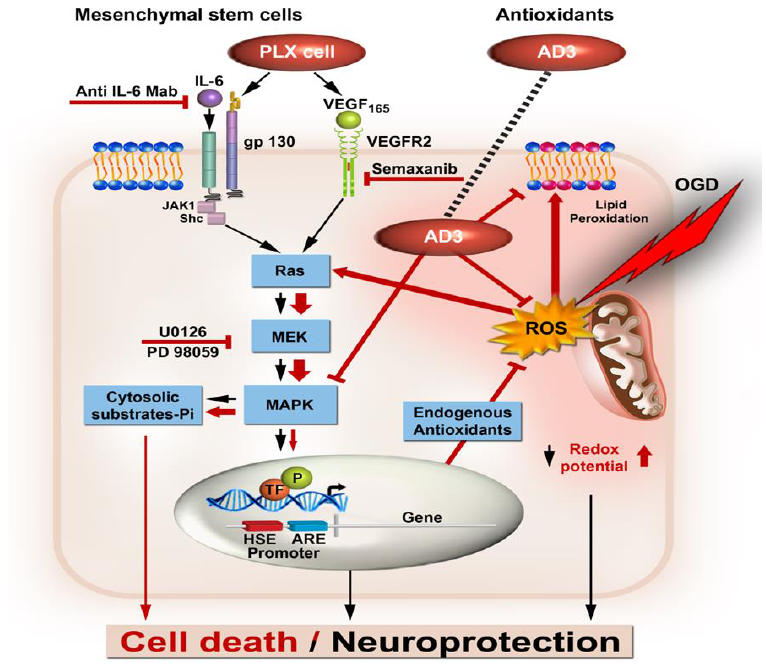
Figure 1. Schematic representation of convergent pathways of neuroprotection generalized for growth factors secreted by mesenchymal stem cells and synthetic antioxidants. Black arrows—physiological pathways; Red arrows—pathological pathways (wider arrow-hyperactivation); Red lighting—oxygen glucose deprivation (OGD); Red bars—inhibitory effect. ARE, antioxidant response element; gp130, glycoprotein 130; HSE, hypoxia response element; IL-6, interleukin 6; Mab, monoclonal antibody; P, Phosphorylated; ROS, radical oxygen species; TF, transcription factor; VEGF, vascular endothelial growth factor.